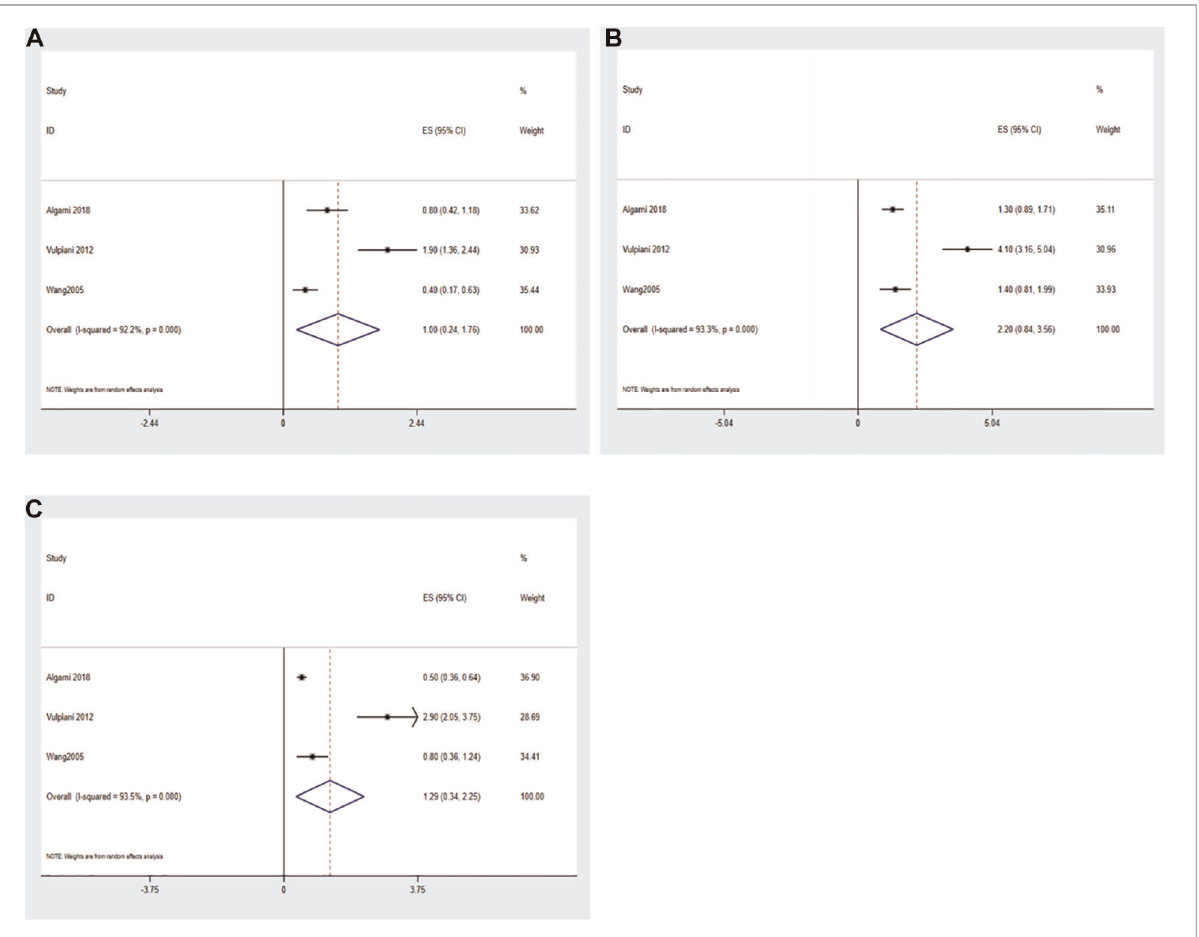
FIGURE 6 Forest plot of VAS. ( A ) The forest plot of the random effects model for a single-arm meta-analysis of 2 studies; ( B ) the forest plot of the random effects model for a single-arm meta-analysis of 3 studies at 6-month follow-up; ( C ) the forest plot of the random effects model for a single-arm meta-analysis of 3 studies at 12-month